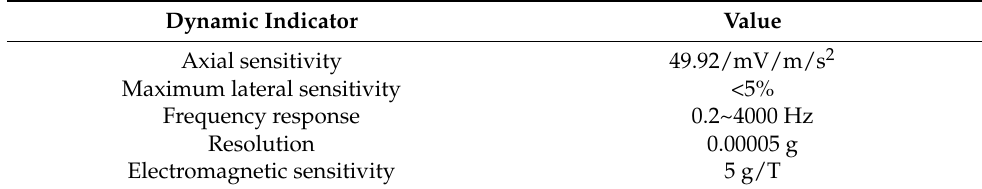
Figure 4. Schematic diagram of acquisition equipment. Table 1. Specific parameters of the sensor 1A212E.